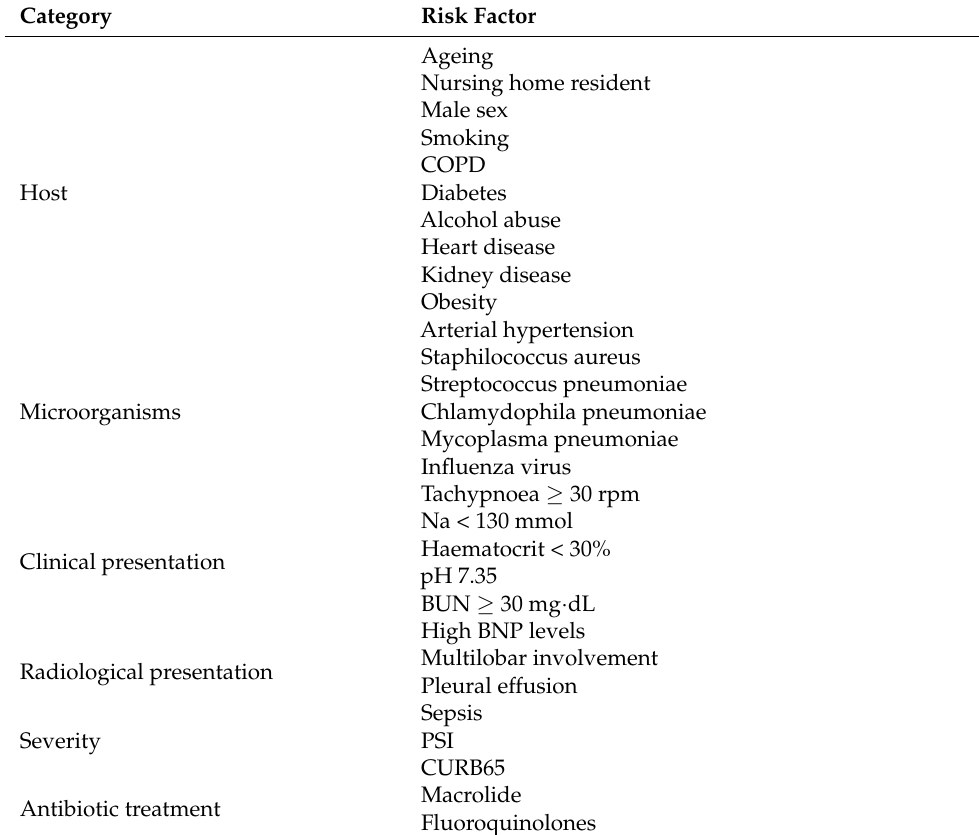
Table 1. Risk factors associated with cardiovascular events in